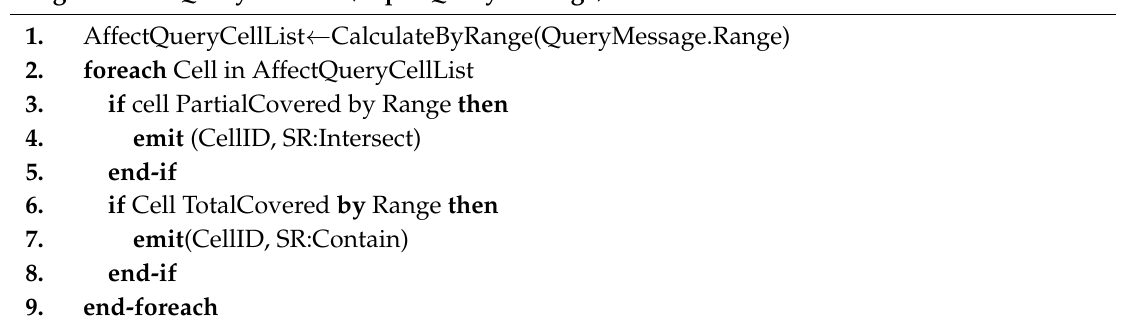
Algorithm 2: QueryPartBolt (Tuple